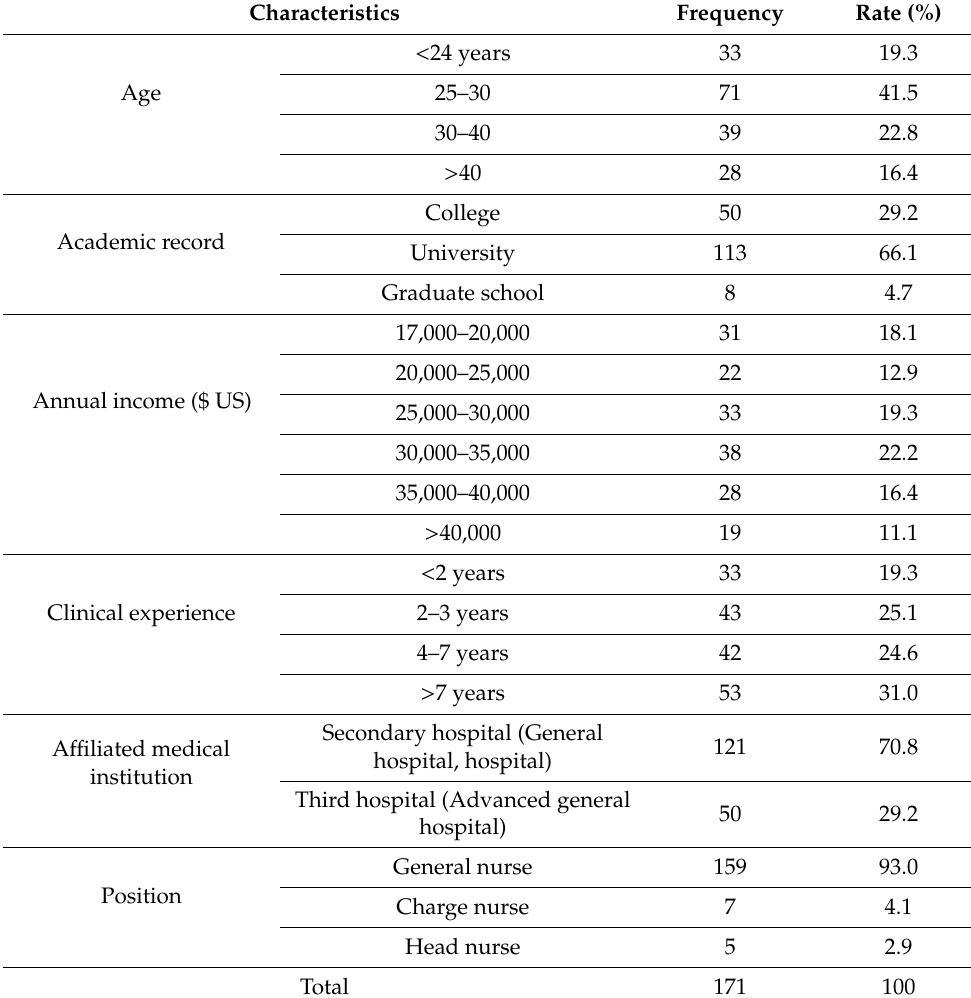
Table 1. Participants’ general characteristics ( N = 171,